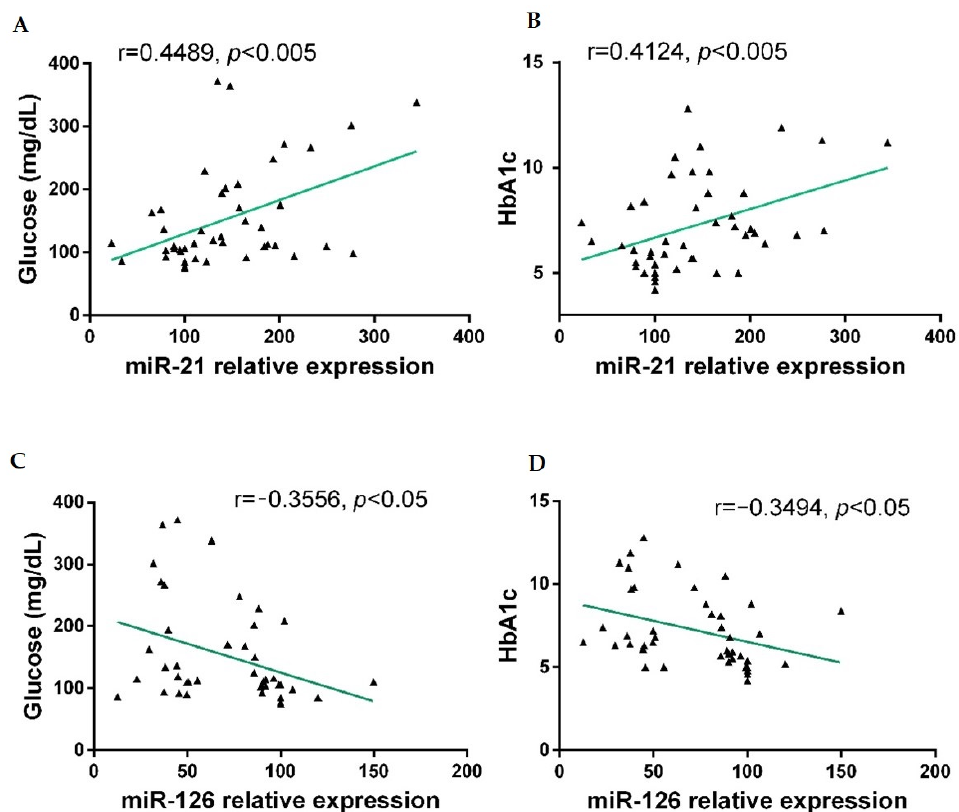
Figure 2. Correlations of relative circulating miR-21 and miR-126 with biochemical parameters in participants were calculated using Pearson correlation coefficient (r) analysis. Correlations between relative miR-21 expression and glucose levels ( A ), miR-21 and HbA1c ( B ), relative miR-126 expression and glucose ( C ), and miR-126 and HbA1c ( D ) were significative.